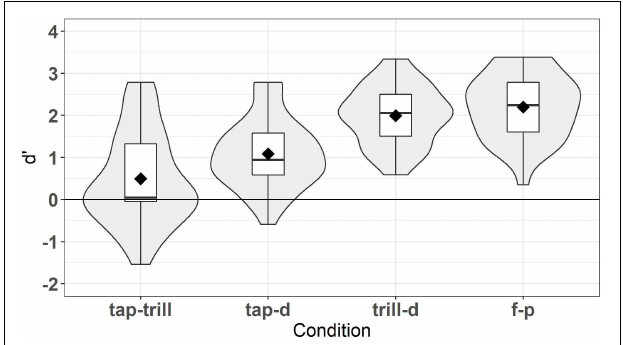
FIGURE 1 | d’ scores for lexical decision